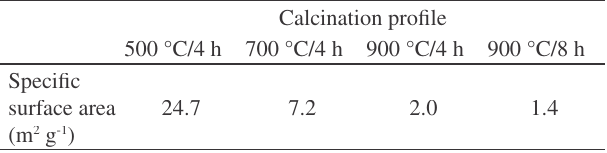
Table 1. Specific surface area of calcined powders.